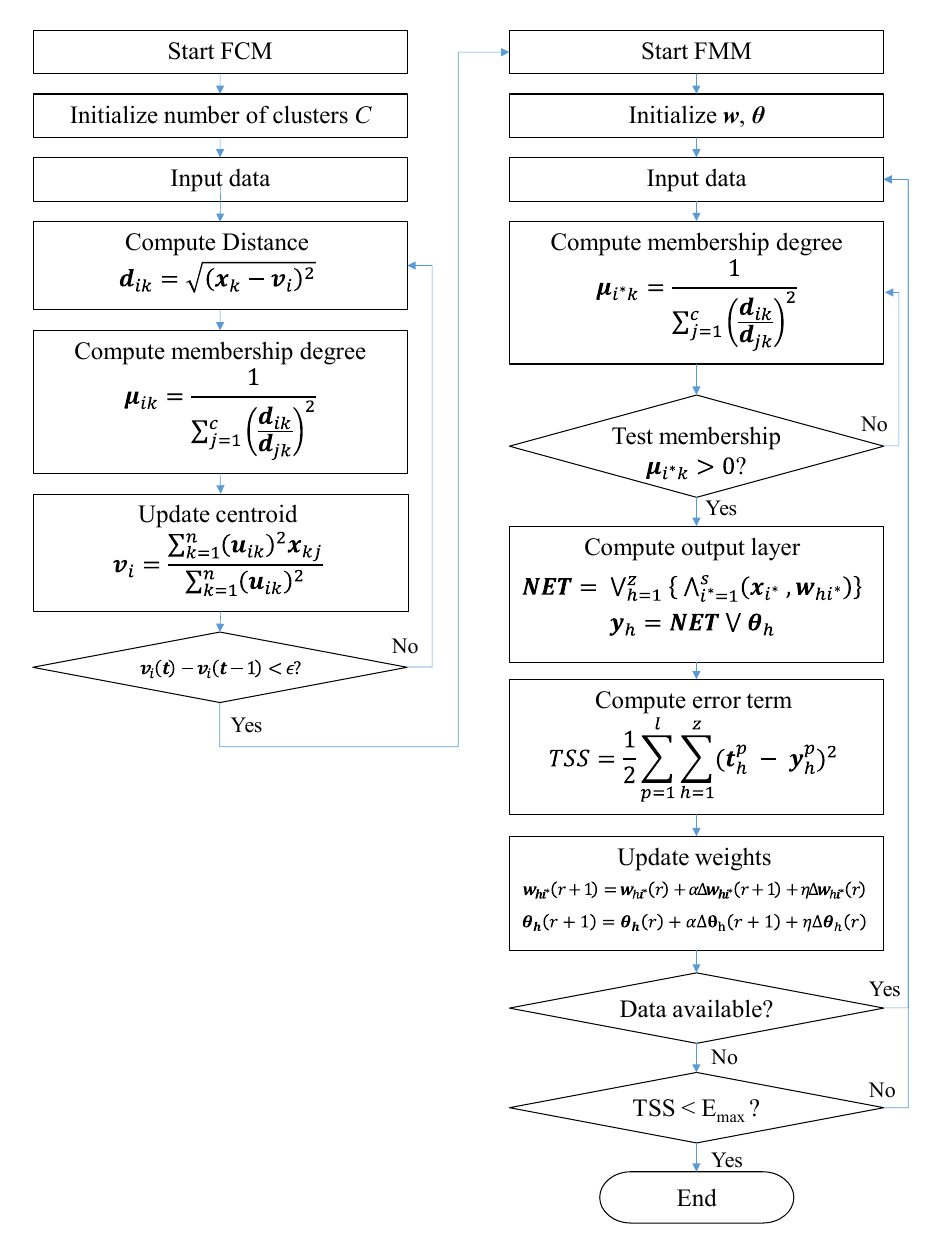
Figure 2. Overall FCM–FMM combination process.